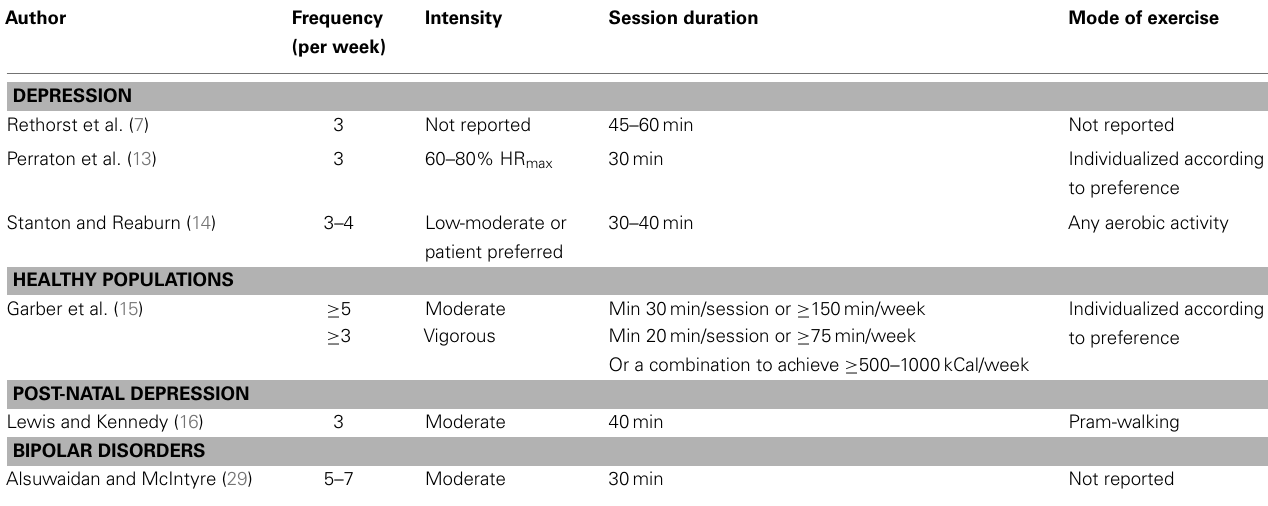
Table 1 | Summary of exercise prescription guidelines